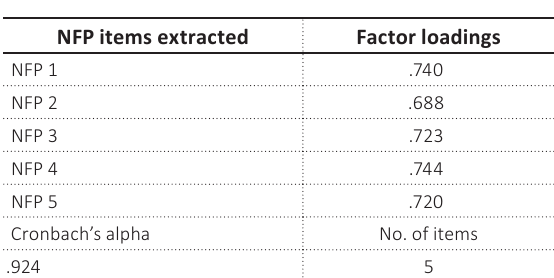
Table 7. Factor: Non-Financial Performance